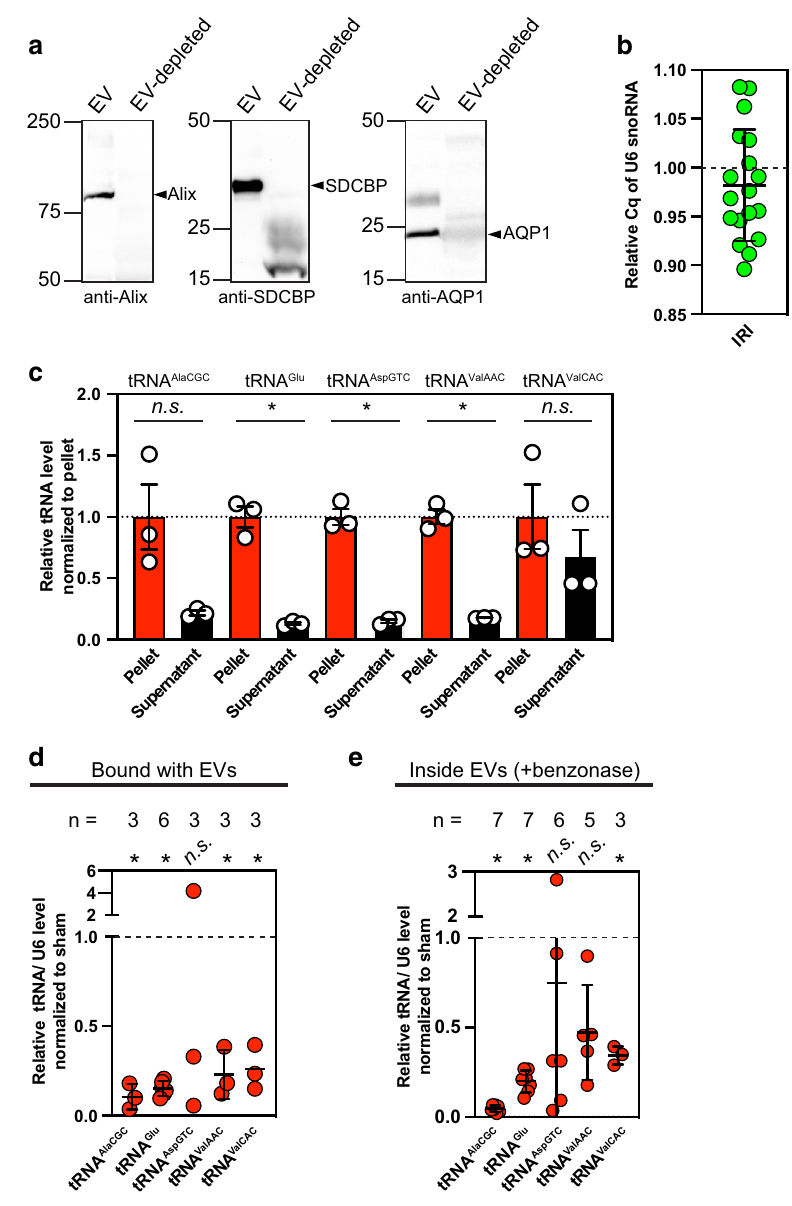
Figure 2. Identification of tRNAs in extracellular vesicles from urine and validation of tRNAs differentially released in extracellular vesicles from renal ischemia/reperfusion injury (IRI). ( a ) Immunoblotting analysis showing the indicated proteins in extracellular vesicle (EV) fraction. As a control experiment, resuspended extracellular vesicles were spun at 200 K × g to produce extracellular vesicle (EV)-depleted condition. ( b ) U6 snoRNA of urinary extracellular vesicles as an adequate reference gene in this experimental condition. Note that the Cq distributions of U6 from urinary extracellular vesicles in IRI were not statistically different. Shown are relative distributions of quantification cycle, Cq of U6 snoRNA from extracellular vesicles of IRI urine normalized to that of sham urine (volume). All urine samples were collected from 24 h after IRI surgery. ( c ) Among urinary tRNAs with decreased expression 24 h after IRI compared with those from sham, tRNA Ala , tRNA Glu , tRNA Asp , and tRNA ValAAC , but not tRNA ValCAC are mainly present in 200 K × g pellets. The bar graph shows the relative levels of the indicated tRNAs from rat urine either in the pellets or supernatants from 200 K × g ultracentrifugation. n.s. statistically non-significant; * p < 0.05. ( d ) Relative abundance of urinary tRNAs from renal IRI that are associated with urinary extracellular vesicles fractionation. Expression levels of the indicated tRNA were normalized using U6 snoRNA within each group, and then relative expression values of tRNA of IRI group normalized to those of sham group were plotted. EV, extracellular vesicles. n.s. statistically non- significant; * p < 0.05. ( e ) Relative abundance of benzonase-resistant, urinary extracellular vesicle tRNAs from renal IRI. Expression levels of the indicated tRNA were normalized using U6 snoRNA within each group, and then relative expression values of tRNA of IRI group normalized to those of sham group were plotted. Note that benzonase was used to measure the abundance of indicated tRNAs which are mostly present inside EVs. EVs, extracellular vesicles. n.s. statistically non-significant; * p <